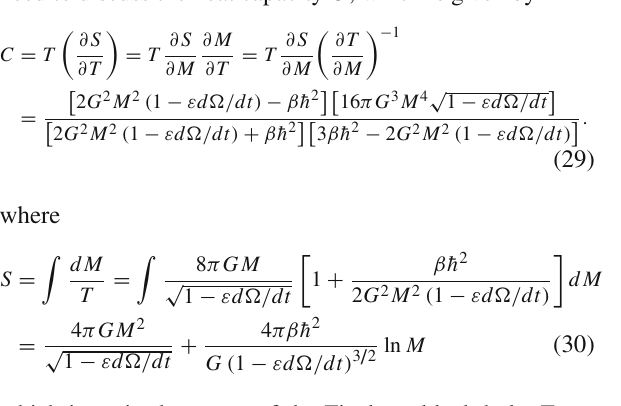
Fig. 2 Plot of the heat capacity with respect to the mass for different β . Green dashed curve corresponds to b = 0 . 5 and β = 0, red curve corresponds to b = 0 . 5 and β = 1